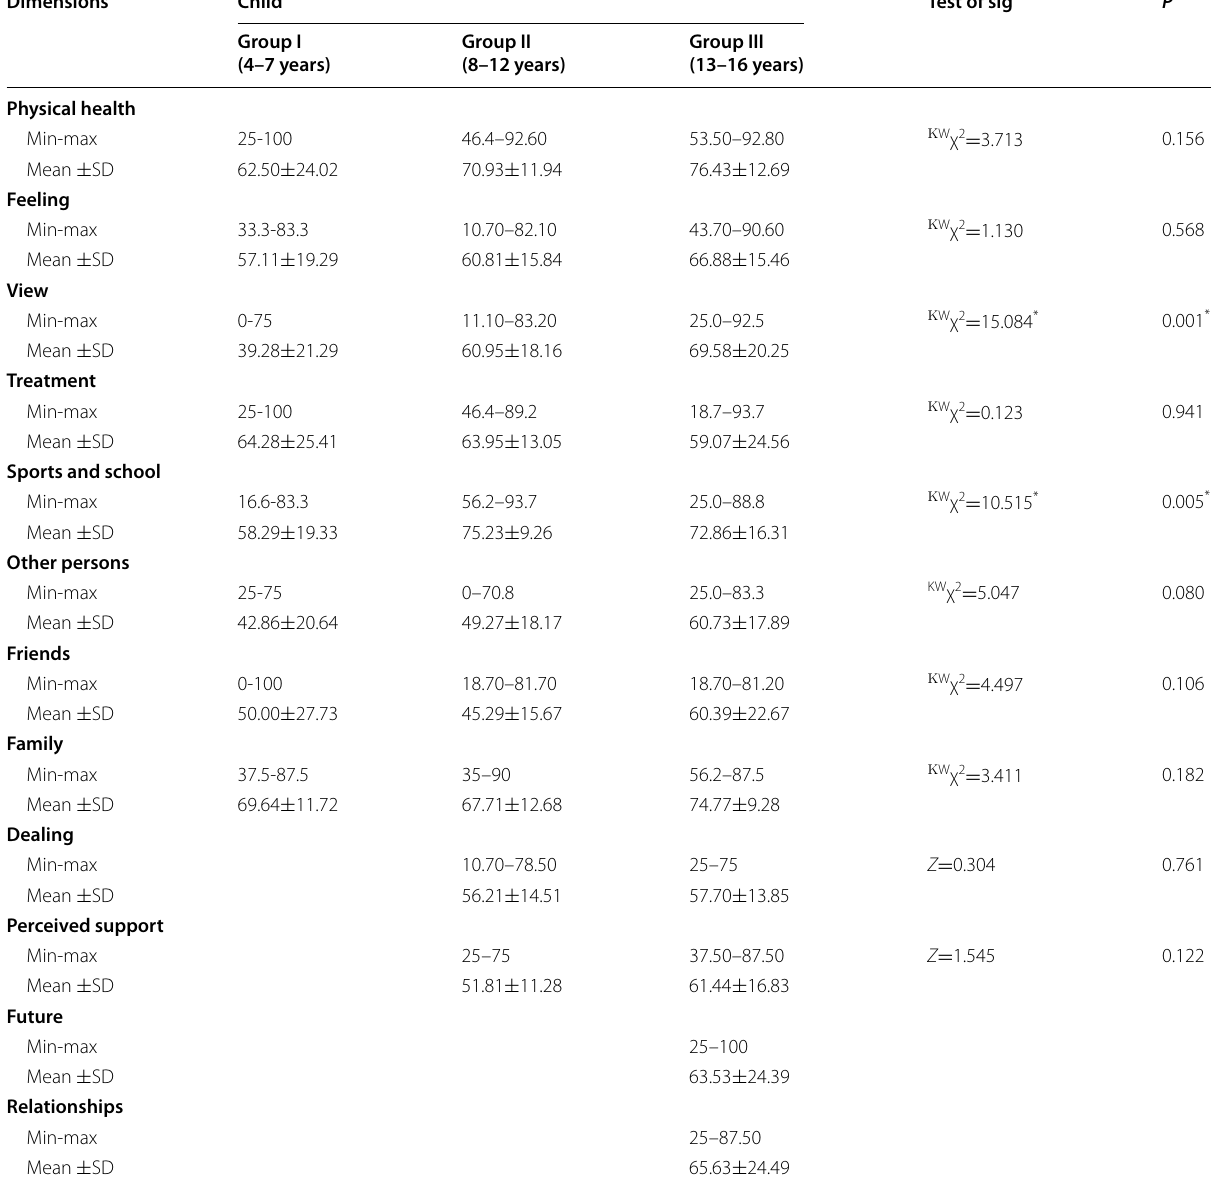
Table 3 Comparison between the child Haemo-QoL score dimensions among the different age groups